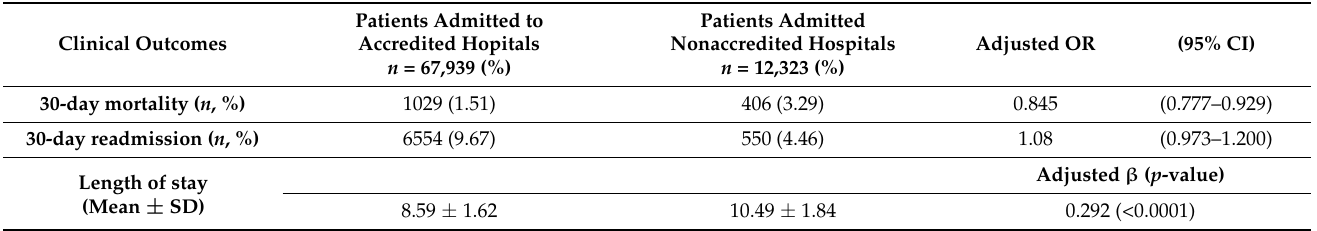
Table 3. Comparisons of three clinical outcomes between accredited and nonaccredited hospitals with multivariate modeling. Clinical